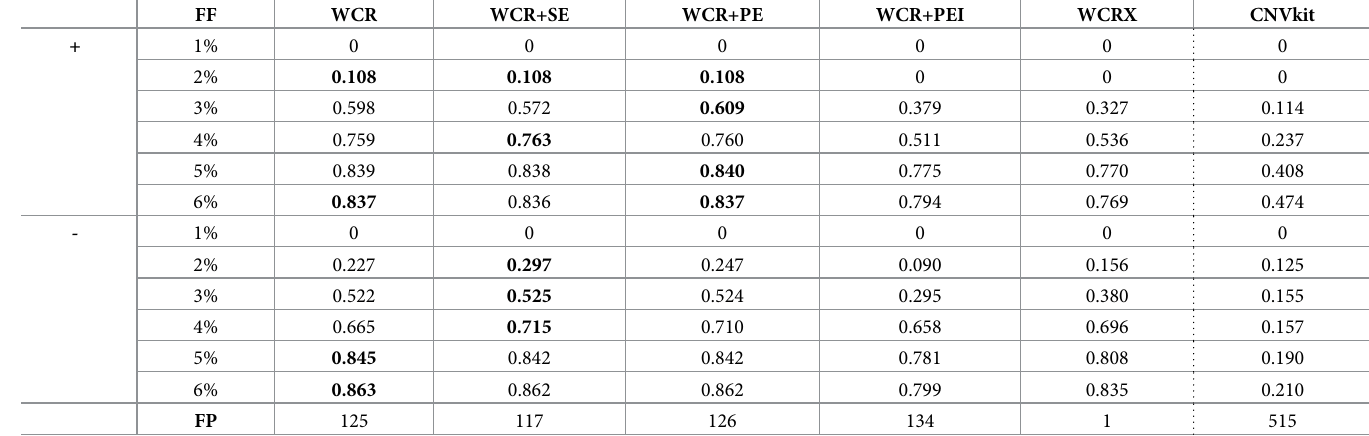
Table 3. Averaged F1 performance in challenging simulated data. F1 score as averaged across all event sizes (0.25 to 5 Mb) for simulated duplication (+) and deletion (-) events across varying fetal fractions (FF), and the number of false positive (FP) calls of the different methods at a 250 kb bin